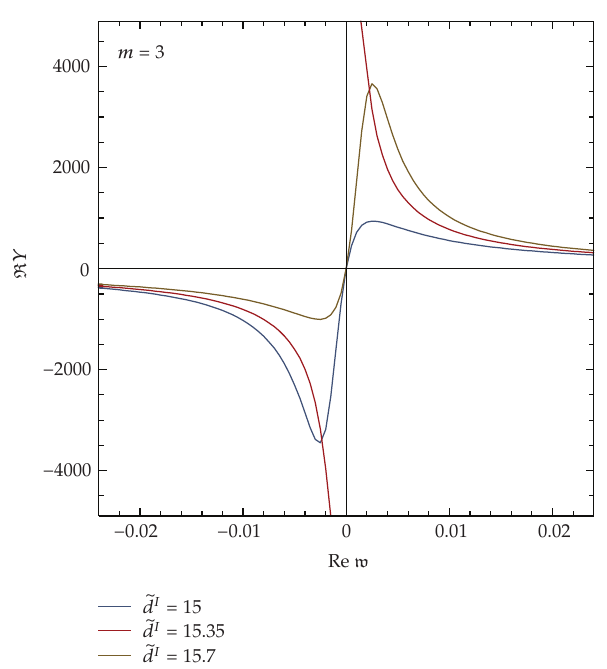
(cid:11) d I (cid:5) 15 . 35 a pole